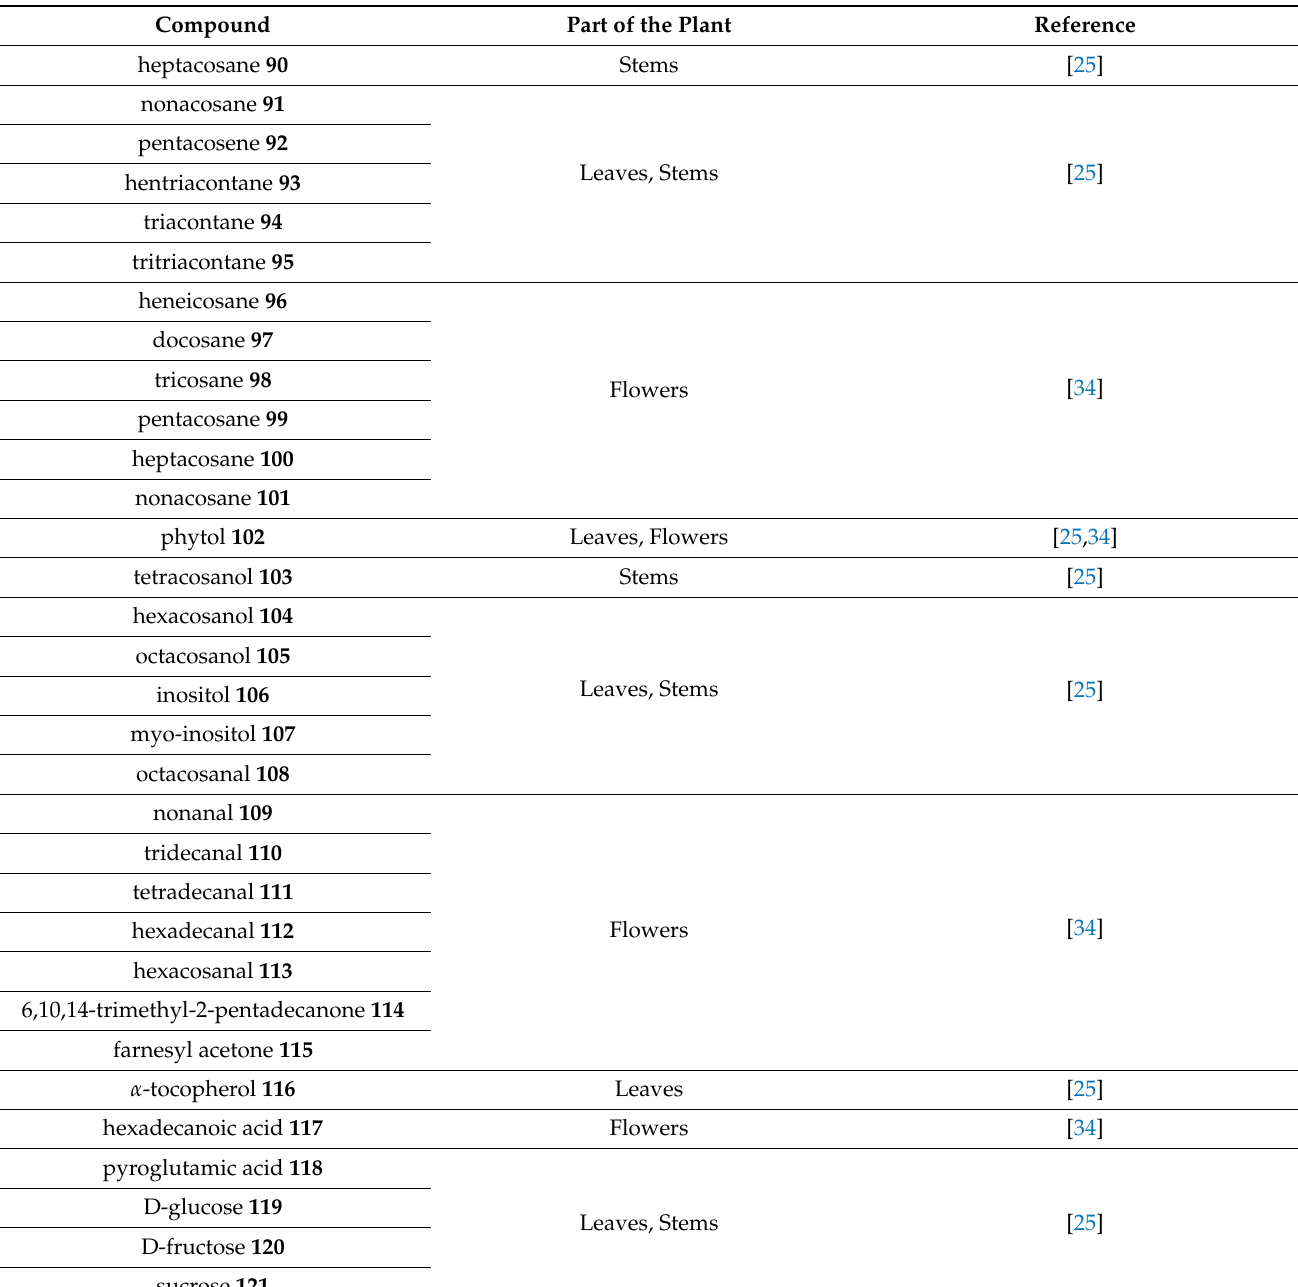
Table 4. Other compounds ( 90 – 121 ) identified from aerial parts of E. characias